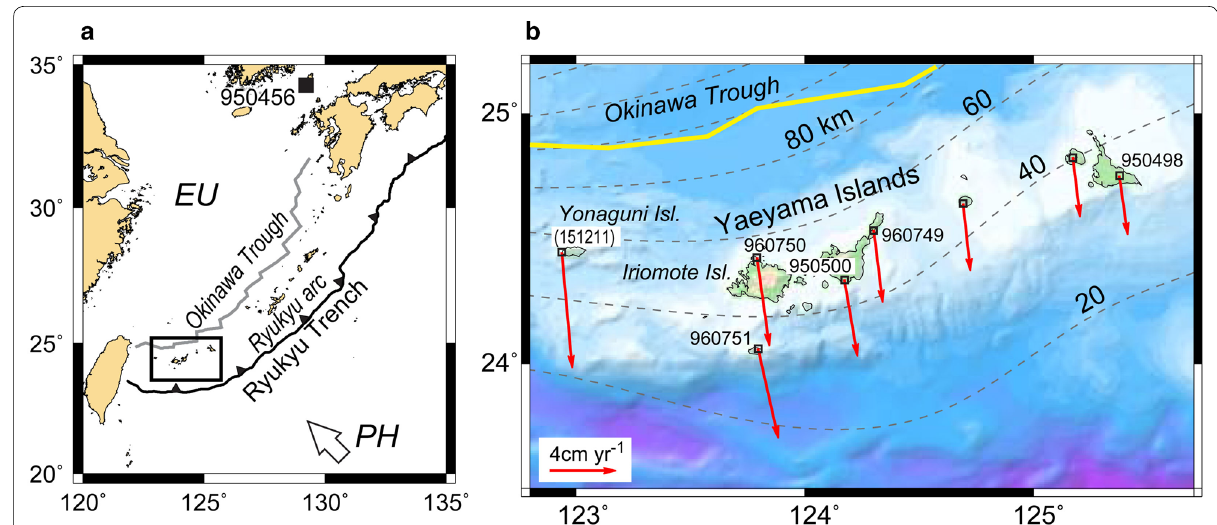
Fig. 1 Location of the Yaeyama Islands and GNSS sites. a Plate tectonic setting of the Ryukyu arc. Rectangle area shows the survey area detailed in b . b GNSS horizontal velocity in the Yaeyama Islands. Red arrows show the average annual velocity of each GNSS site between January 2007 and December 2017 with reference to site 950546 in Fig. 1a. The annual velocity at site 151211 was calculated between January 2017 and December 2017. Contours show the depth of the subducted Philippine Sea plate (Lindquist et al. 2004; Iwasaki et al.